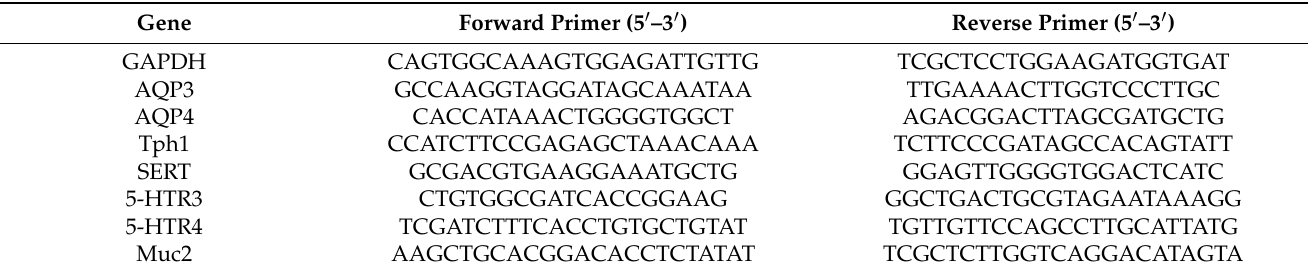
Table 1. Primers used to quantify mRNA in colonic tissue of mice in the experimental model with